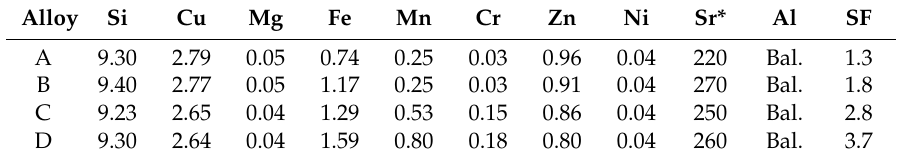
Table 1. Alloys’ chemical compositions measured by OES (wt %, except for Sr* in ppm) and corresponding SF.